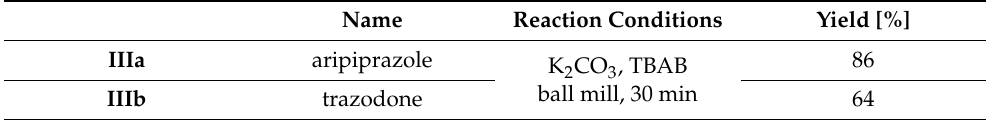
Table 2. Synthesis of aripiprazole, trazodone in the presence of potassium carbonate and TBAB in